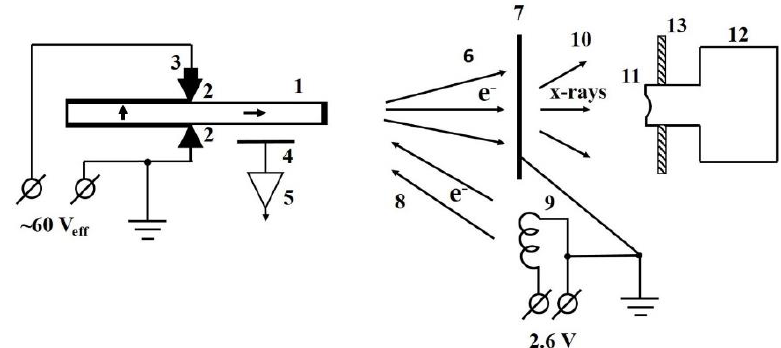
Figure 1. The experimental setup. Ceramic piezoelectric transformer 1 is installed between contacts 2 ; two low-voltage and one high-voltage silver electrodes of the piezoelectric transformer are shown by bold lines; one of the contacts is supplied by digital thermometer 3 ; the sine signal from the electric field probe 4 penetrates to the input of the amplifier 5 ; electrons 6 are accelerated from the high voltage electrode towards a thin target 7 during negative high voltage half-wave; electrons 8 move from the filament 9 towards the high voltage electrode during positive high voltage half-wave; X-rays 10 from the target reach the entrance Be window 11 of the X-ray detector 12 ; the entrance widow of the detector is sunk into the vacuum chamber through the flange 13 . Polarization directions are shown by bold arrows in the ceramic piezoelectric transformer bar.